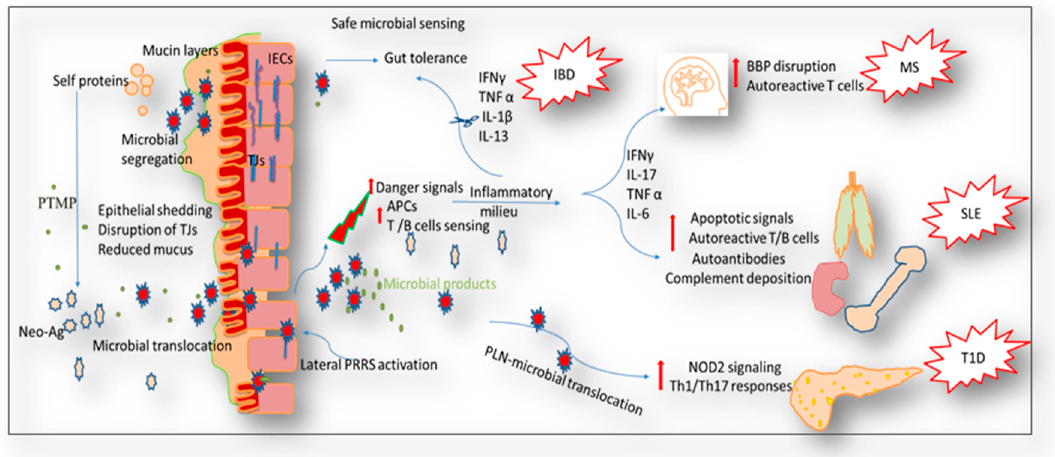
Figure 2. Possible mechanisms of how a leaky gut leads to autoimmunity. Breakdown of the integrity of the intestinal mucosa is associated with microbial dysbiosis. This could result in epigenetic changes of both self-protein and pattern recognition receptor (PRR) sensing. Increased danger signals following microbial dysbiosis provoke immunogenic cell responses, consequently upregulating different pro-inflammatory cytokines levels such as tumor necrosis factor (TNF) α , IFN γ , IL-1, IL-17, IL-6, and IL-13. These inflammatory niches are associated with different pathologies including IBD, MS, SLE, and T1D.